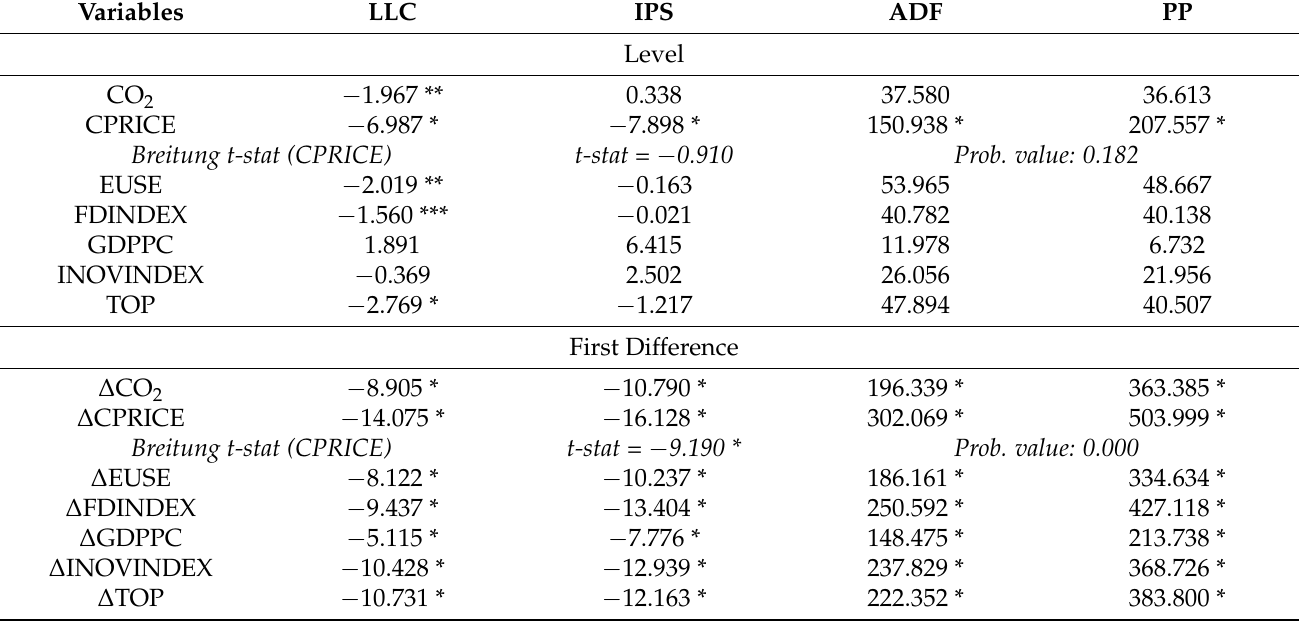
Table 5. Summary of Panel Unit Root